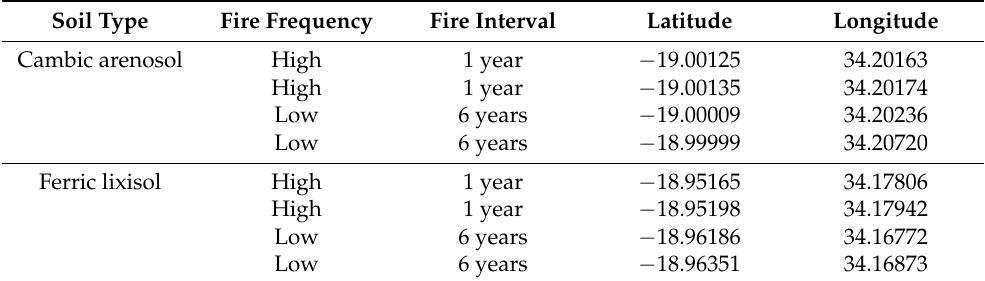
Table 1. Sampling information: soil type, fire frequency, and geographical coordinates. Soil Type Fire Frequency Fire Interval Latitude Longitude Cambic arenosol High 1 year